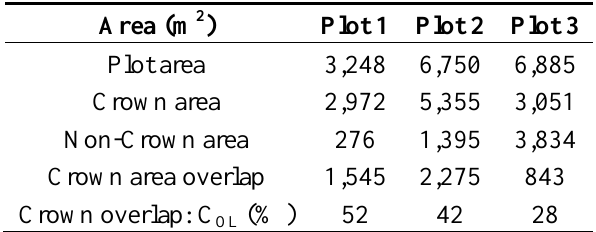
Table 4. Descriptive statistics for the collected